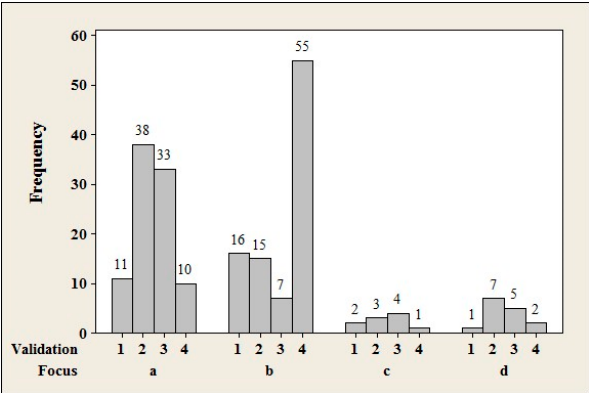
Figure 8. Summary of validation of ITCD and related literature by research focus (Validation code-1: Stand/plot level; 2: Individual tree level; 3: Both levels; 4: No validation; Focus code-a: Algorithm development; b: Application; c: Both algorithm development and application; d: Method comparison or review) ( N = 210).